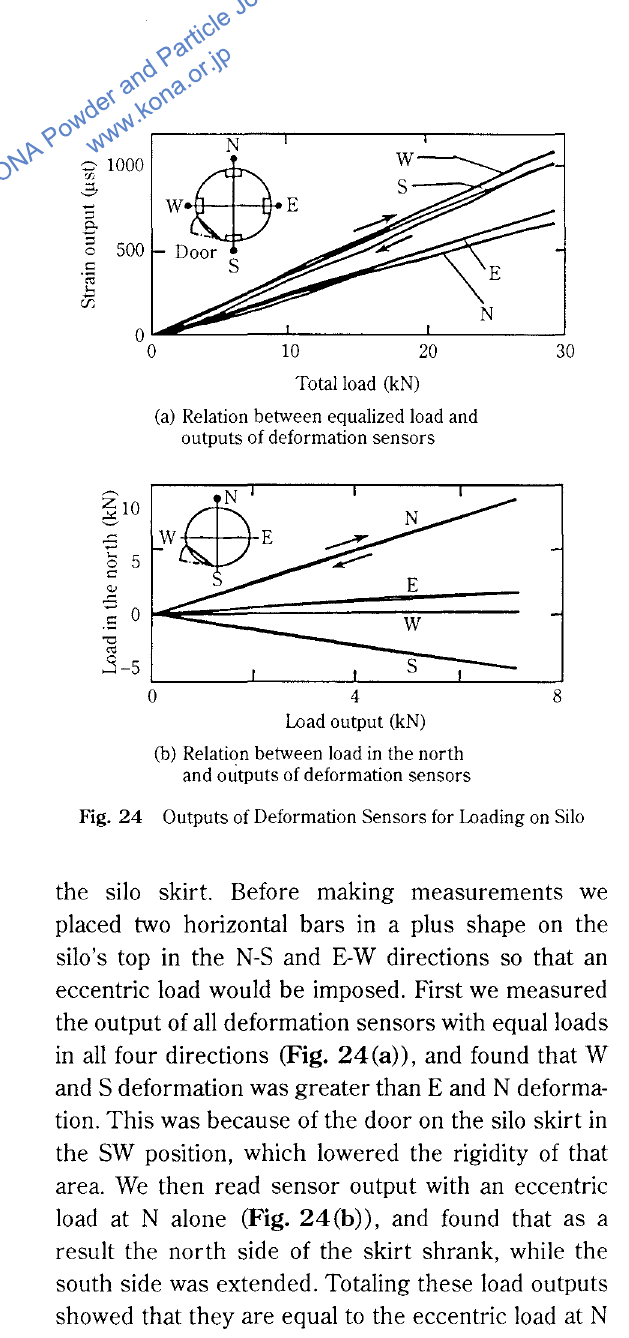
Fig. 24 Outputs of Deformation Sensors for Loading on Silo